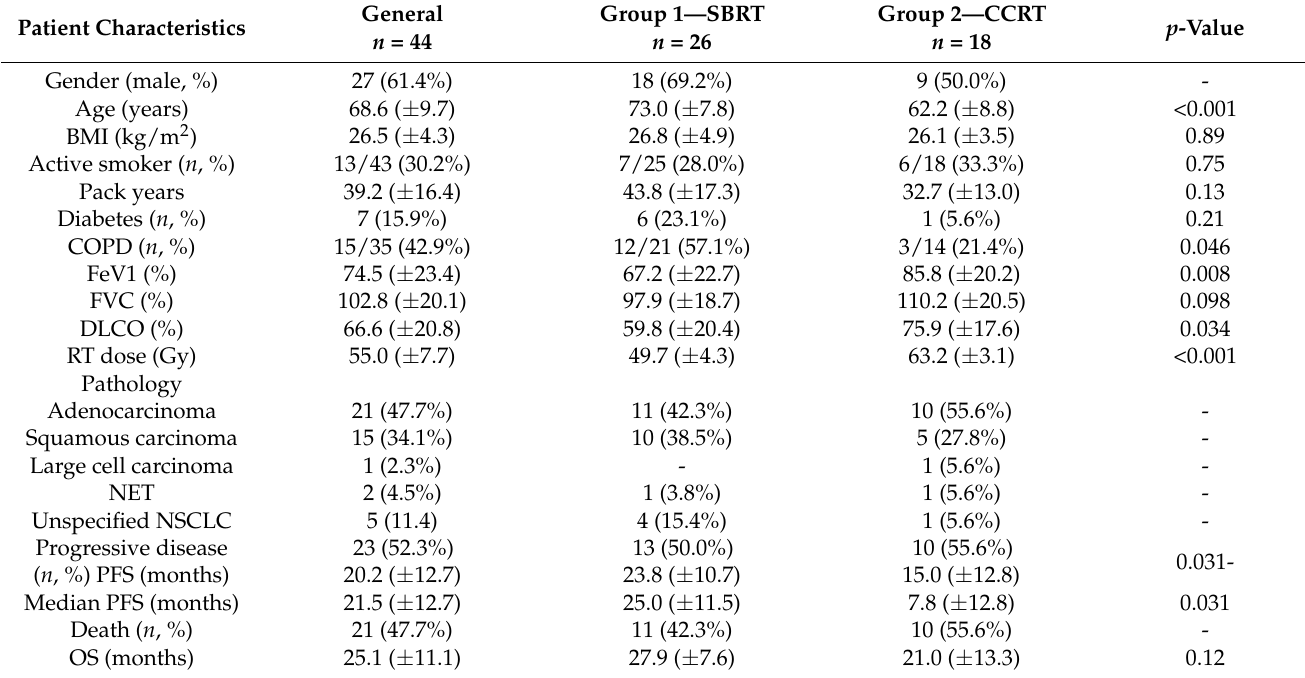
Table 1. Patient